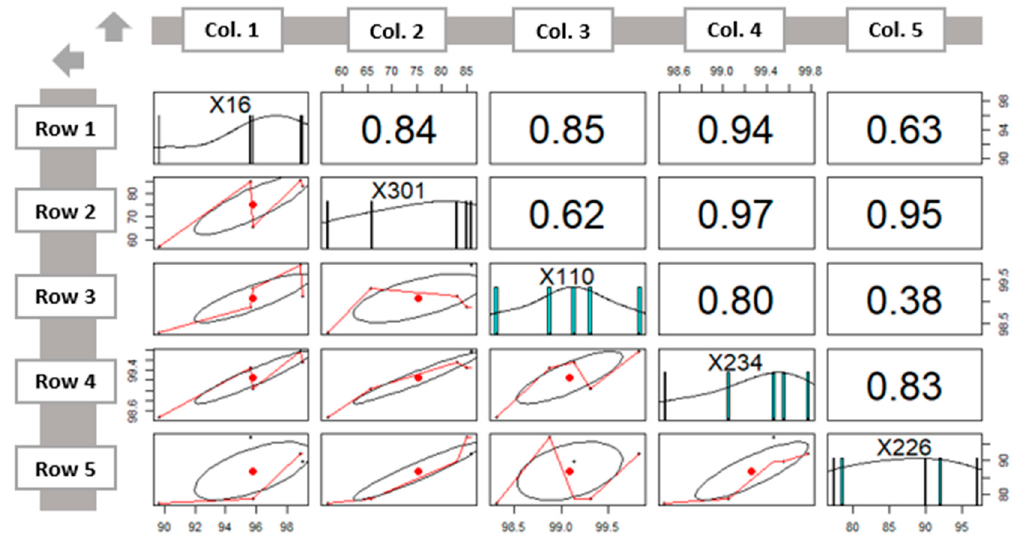
Figure 8. Contingency table for the Co-Active elements in the ‘RC110’ group.